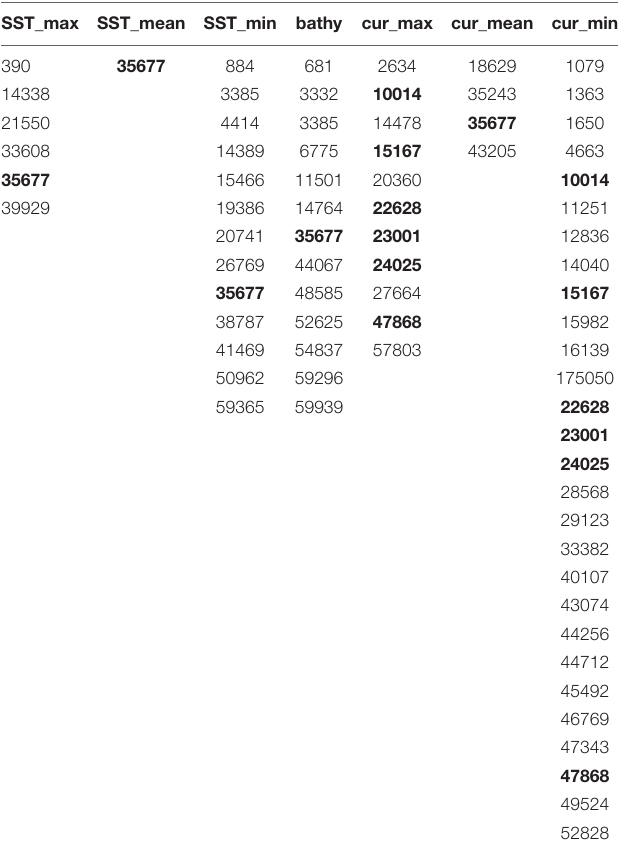
TABLE 3 | Environmentally linked loci under putative selection based on latent factor mixed model (LFMM) and redundancy (RDA)